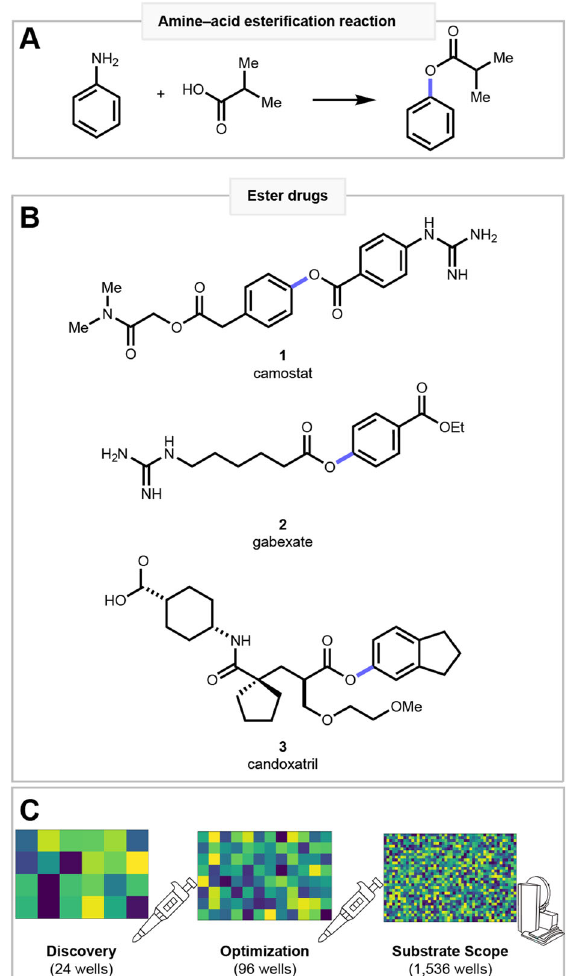
Fig. 1 HTE enabled amine – acid esteri fi cation and its application in drug molecules. A The amine – acid esteri fi cation. B Esters are an important medicinal functionality as in drugs 1 – 3 . C Reaction discovery, optimization, and scope pro fi ling is achieved using